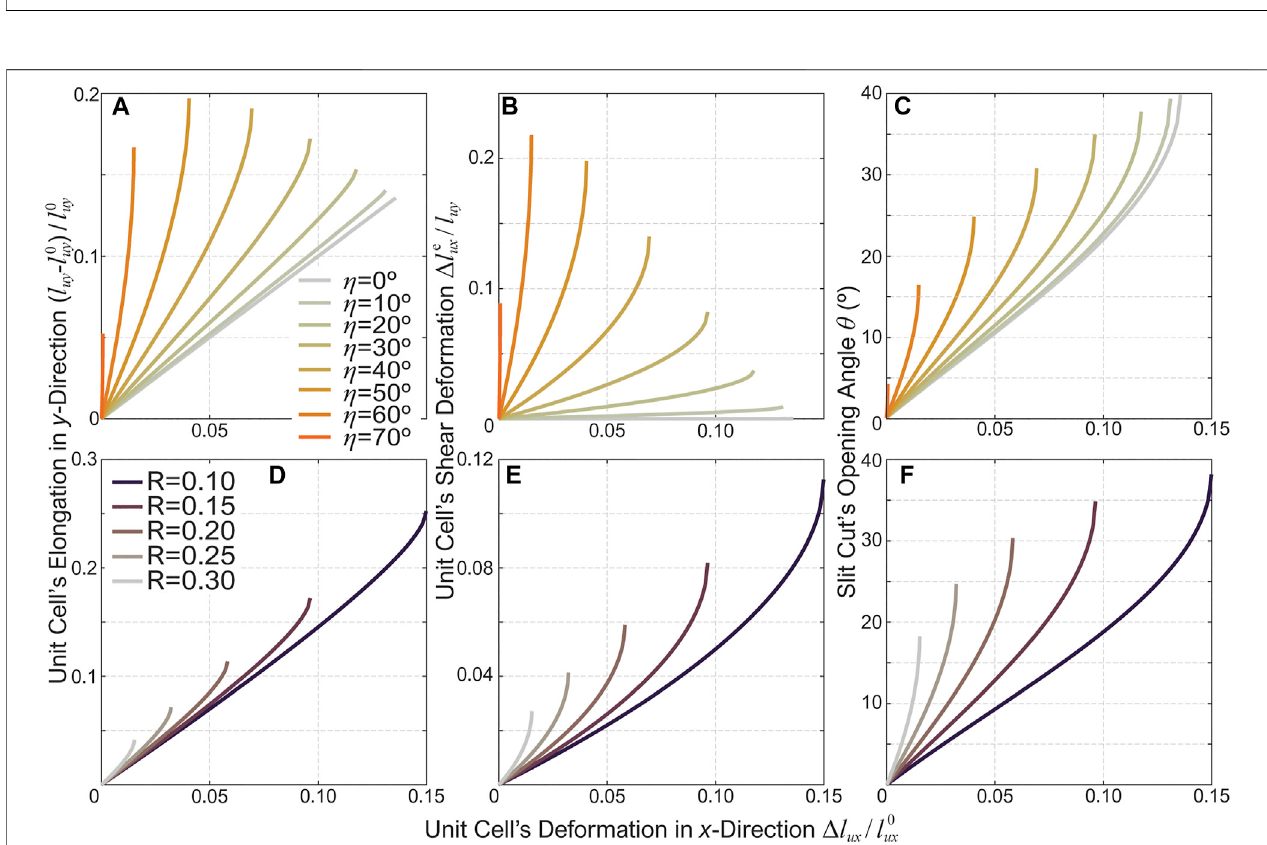
FIGURE4| Parametricanalysisresults showing thecorrelation between thekirigami cutting pattern design and the actuator ’ s motioncharacteristics. The fi rstrow (A-C) showstheresultsfromkirigamiskinswiththesamecutratio( R (cid:1) 0.15)butdifferentinclineangles,whilethesecondrow (D-F) showstheresultsbasedonthesame incline angle ( η (cid:1) 30 ° ) but different cut ratios. The left column (A,D) shows the normalized unit cells ’ axial expansion, the middle column (B,E) shows the unit cells ’ shearing, and the right column (C,F) show the opening angle θ of the slit cuts.